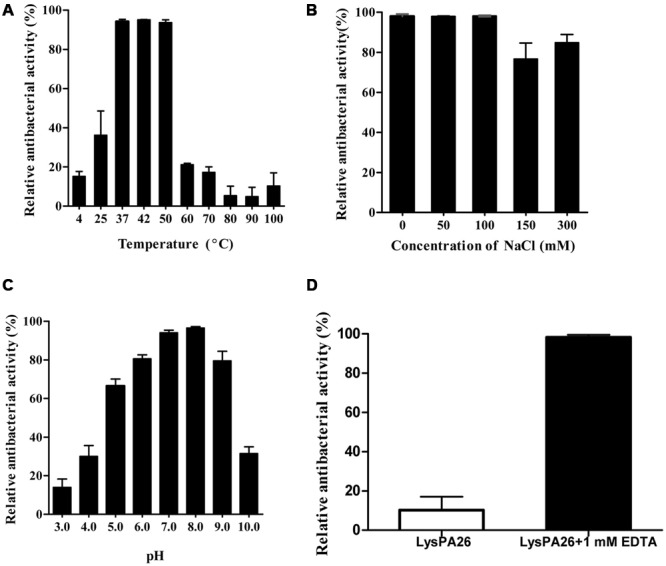
Influence of temperature, NaCl and pH conditions on the bactericidal activity of LysPA26. (A) The effects of temperature on the lytic activity of LysPA26. LysPA26 (0.5 mg/ml) was added to test bacterial suspensions and incubated for 30 min at different temperatures to determine the bactericidal assay. (B) The influence of saline concentration on the bactericidal activity of LysPA26. LysPA26 (0.5 mg/ml) was added to test bacterial suspensions under different NaCl concentrations to determine the antimicrobial activity. (C) The influence of pH on the lytic activity of LysPA26. LysPA26 (0.5 mg/ml) was incubated with buffers with different pH values (50 mM sodium acetate for pH 4.0–6.0 and 20 mM Tris-HCl for pH 7.0–11.0) for 30 min to determine the antimicrobial activity. (D) Thermo-stability of LysPA26. LysPA26 (0.5 mg/ml) was incubated at 100°C for 10 min before determining the antimicrobial activity in the absence of EDTA or with 1 mM EDTA. Bactericidal activity is presented as the relative inactivation. Error bars represented the standard deviations of three independent assays.